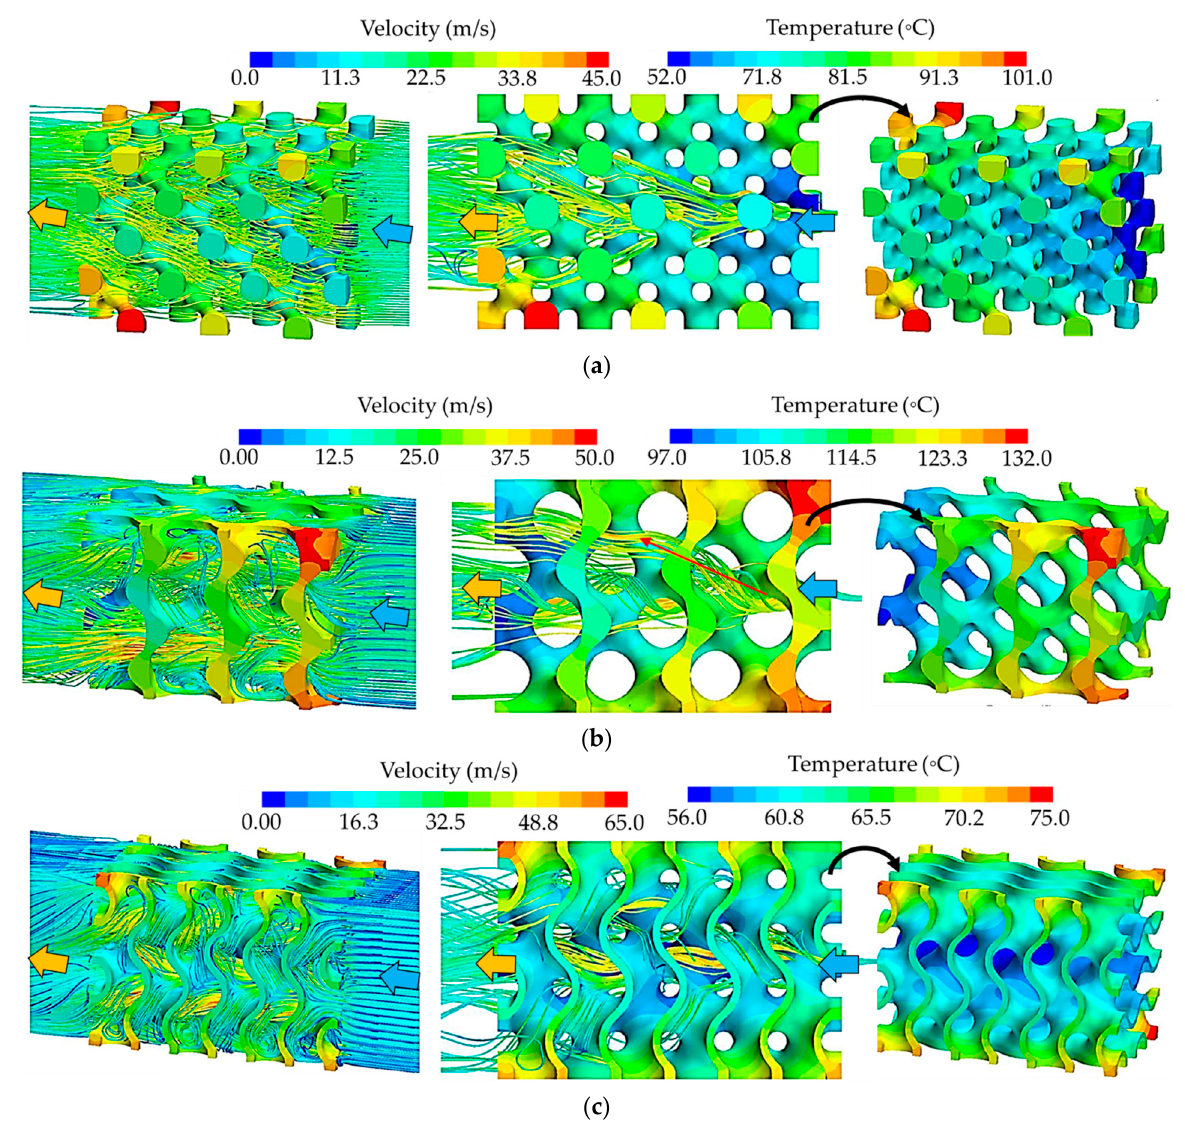
Figure 9. Velocity streamlines and temperature contours at Re = 27,500 and heat load = 100 W [53]: ( a ) Solid-Diamond; ( b ) Solid-Gyroid; ( c ) Sheet-Gyroid structures.